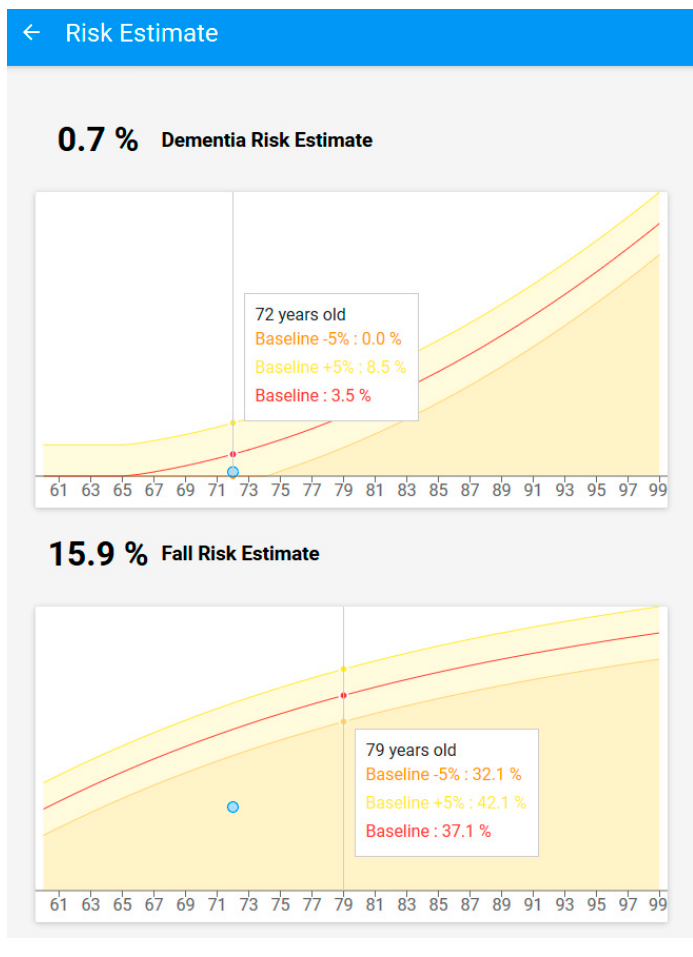
Figure 6. Risk Values example.